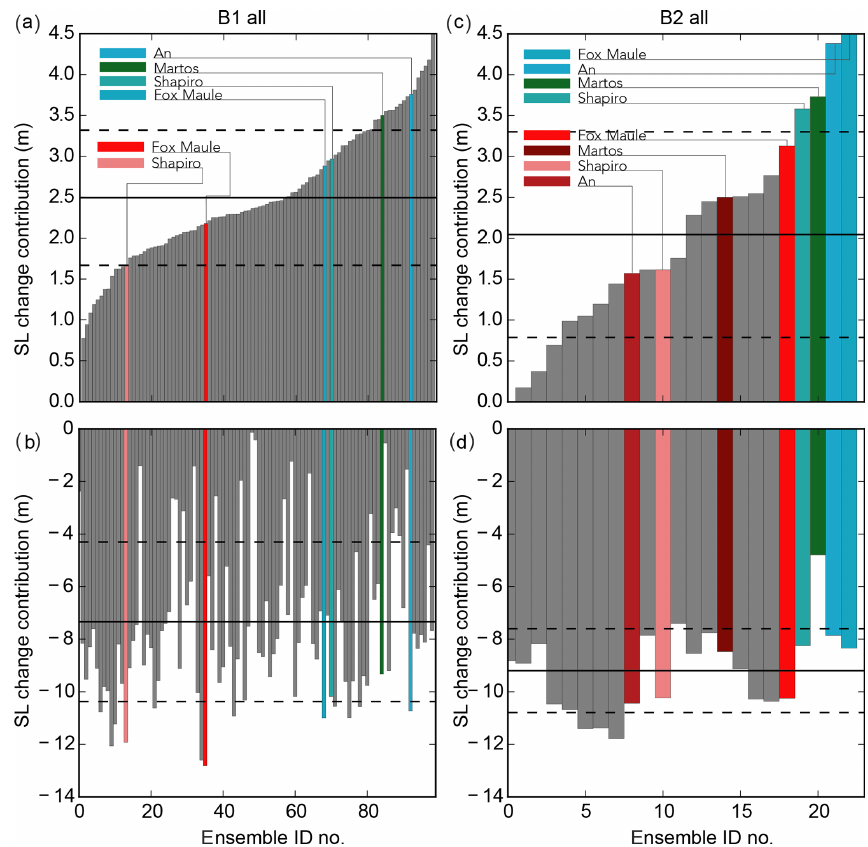
Figure 8. Sea level contribution in the LIG ( a and c ) and LGM ( b and d ) for the full ensemble forced with climate index B1 and B2. The ensemble members focused on in this paper are highlighted by colours (P1, red colours; P2, blue/green colours). Horizontal black lines depict the full ensemble means and the dashed lines the standard deviations. The x axis shows the individual ensemble IDs in ascending order of LIG SL